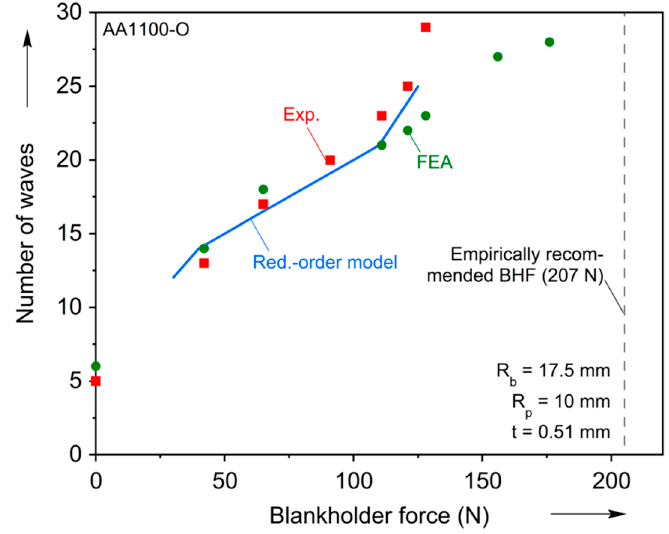
Figure 16. Wave numbers at the onset of flange wrinkling for different BHFs, including experimental results and predictions from the reduced-order model and finite element model.